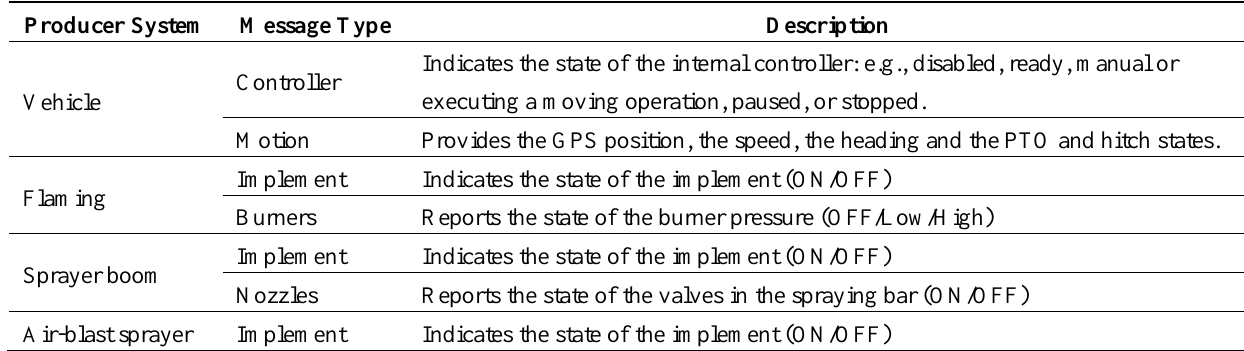
Table 2. UCS monitoring